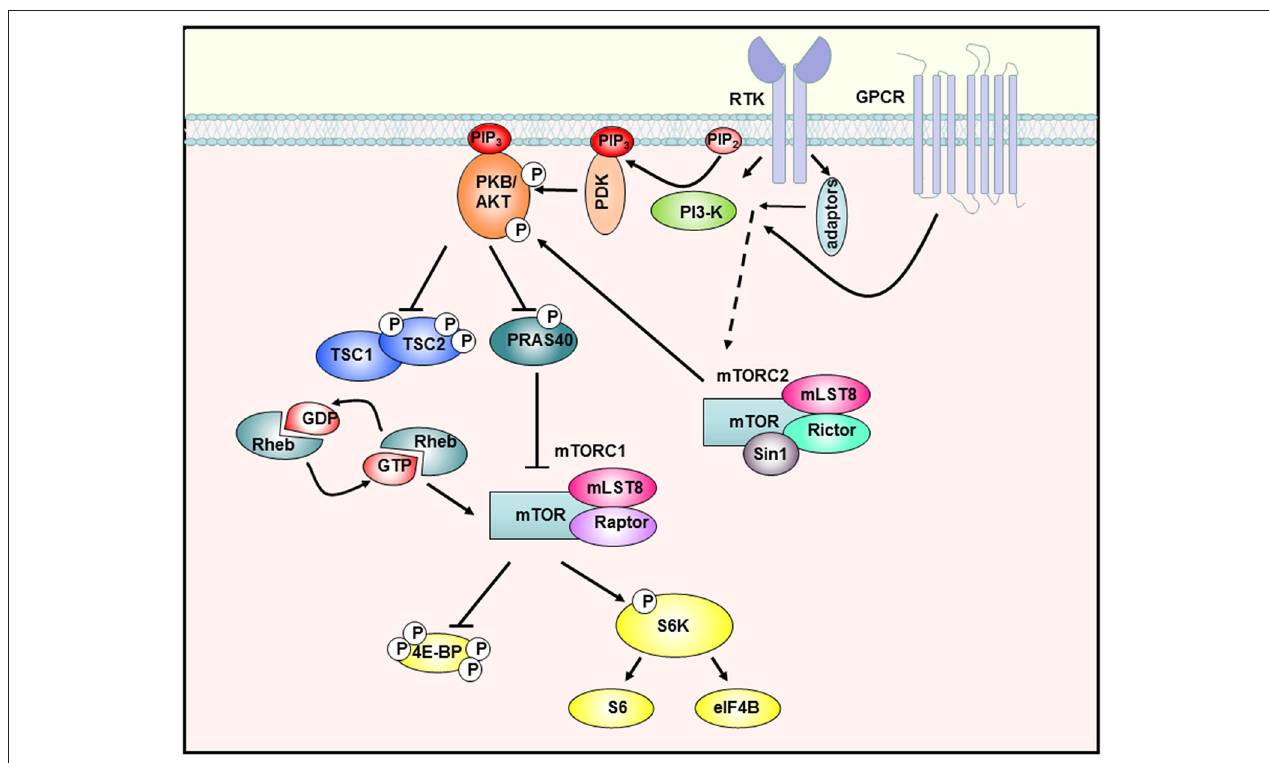
FIGURE 1 | The PI3-K/Akt/mTOR signaling cascade. Stimulation of receptor tyrosine kinases (RTK) and G-protein-coupled receptors (GPCR) leads to activation of PI3-K, which then synthesizes PIP 3 in the membrane. Subsequently, Akt is recruited to the membrane and phosphorylated by PDK-1 and mTORC2. The activated Akt kinase phosphorylates various substrates such as PRAS40, which is then inactivated and releases mTORC1. In addition, TSC2 is inhibited so that the downstream GTPase Rheb remains GTP-bound and can activate mTORC1. The fully activated mTORC1 complex then activates proteins of the translation machinery by phosphorylating S6K-1 or 4E-BP1 [adapted from Manning et al. (